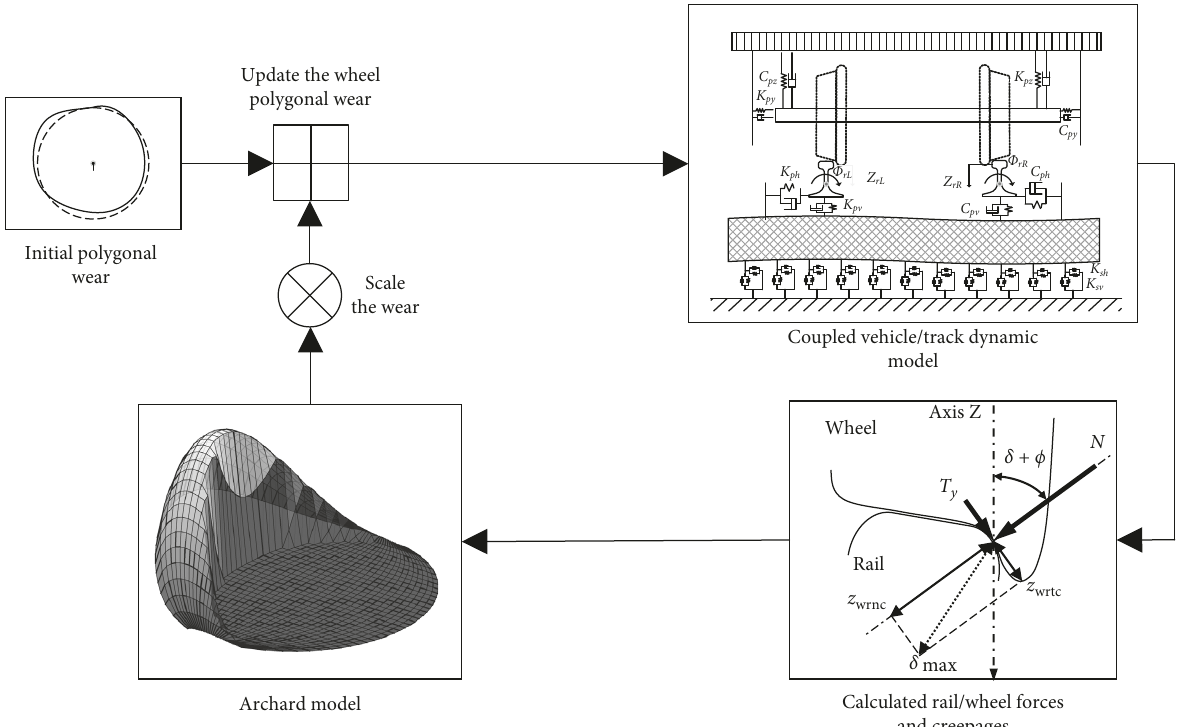
Figure 13: Flow chart of long-term wheel polygonalization wear iteration.